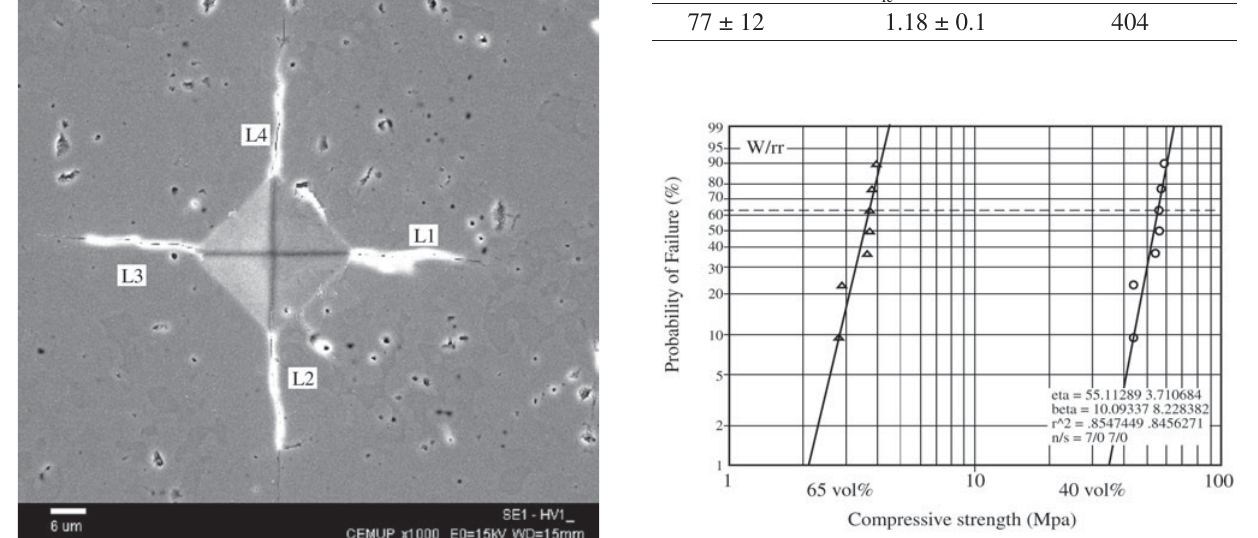
Figure 2. Probability of failure of porous GR-HA discs vs. compressive